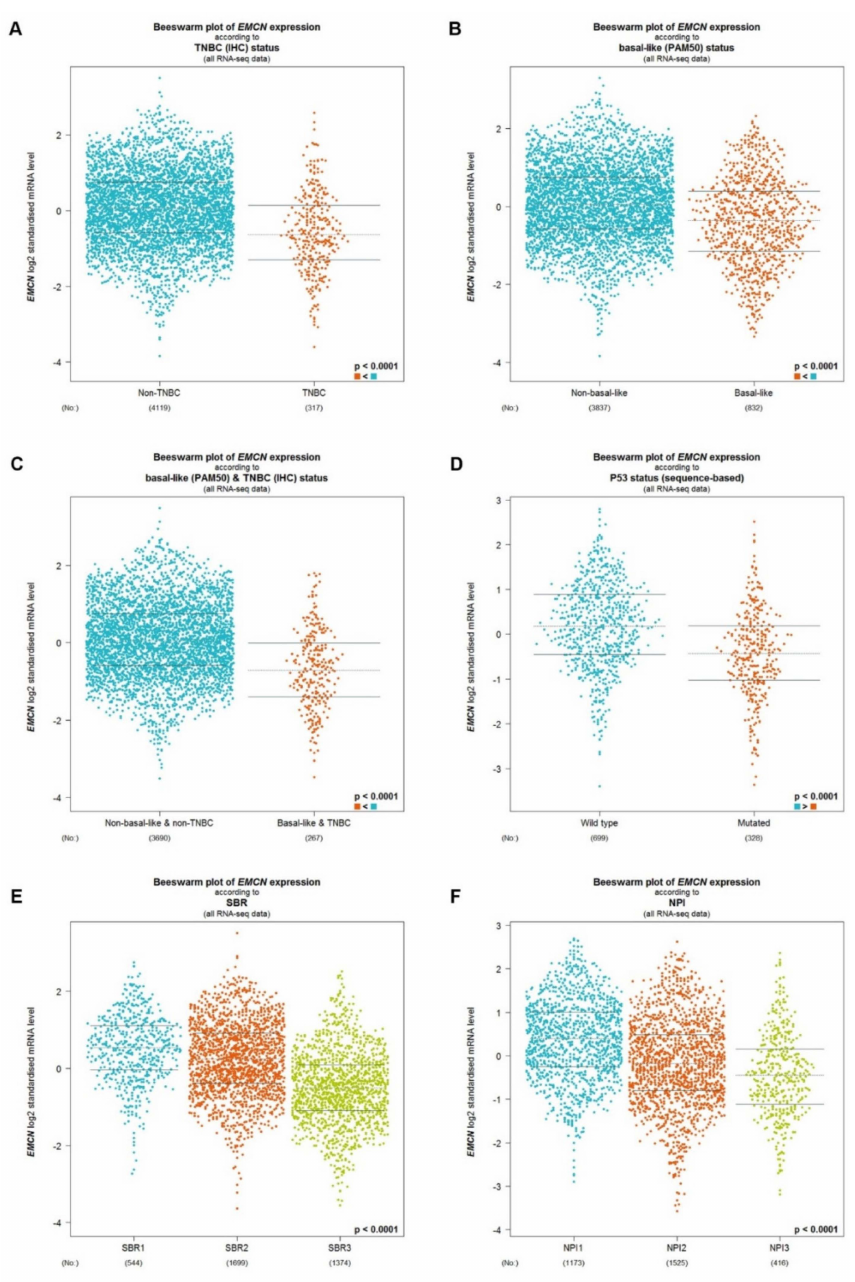
Figure 4. Expression differences of MUC14 in breast cancer based on different clinicopathological features. ( A ) MUC14 expression in non-TNBC and TNBC. ( B ) MUC14 expression in non-basal-like and basal-like breast cancer. ( C ) MUC14 expression in non-basal-like breast cancer & non-TNBC and basal-like breast cancer & TNBC. ( D ) MUC14 expression in P53 wild type and mutated breast cancer. ( E ) MUC14 expression in breast cancer based on various SBR grade. ( F ) MUC14 expression in breast cancer based on various NPI score. “ p < 0.05” was considered as statistically